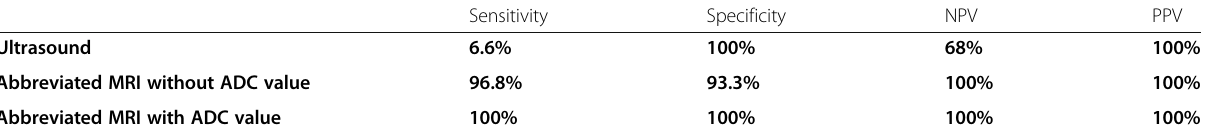
Table 3 Sensitivity, specificity, NPV, and PPV of US, abbreviated MRI protocol with and without ADC value in the detection of a malignant focal lesion in correlation with